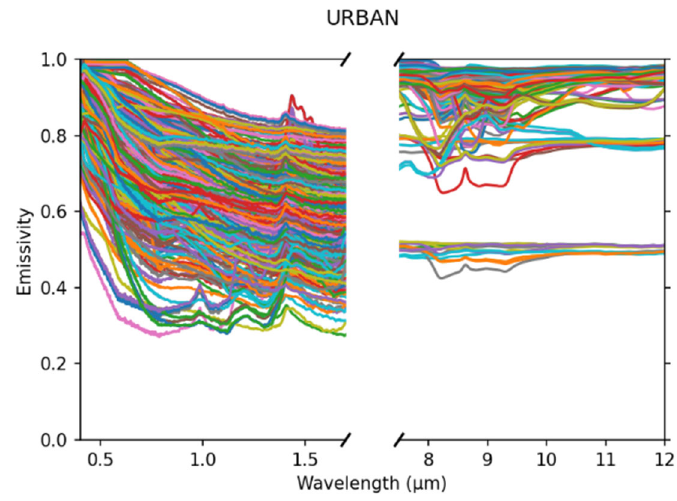
Figure 6. VNIR-SWIR ( left ) and TIR ( right ) Emissivity of the ECO121 urban database.